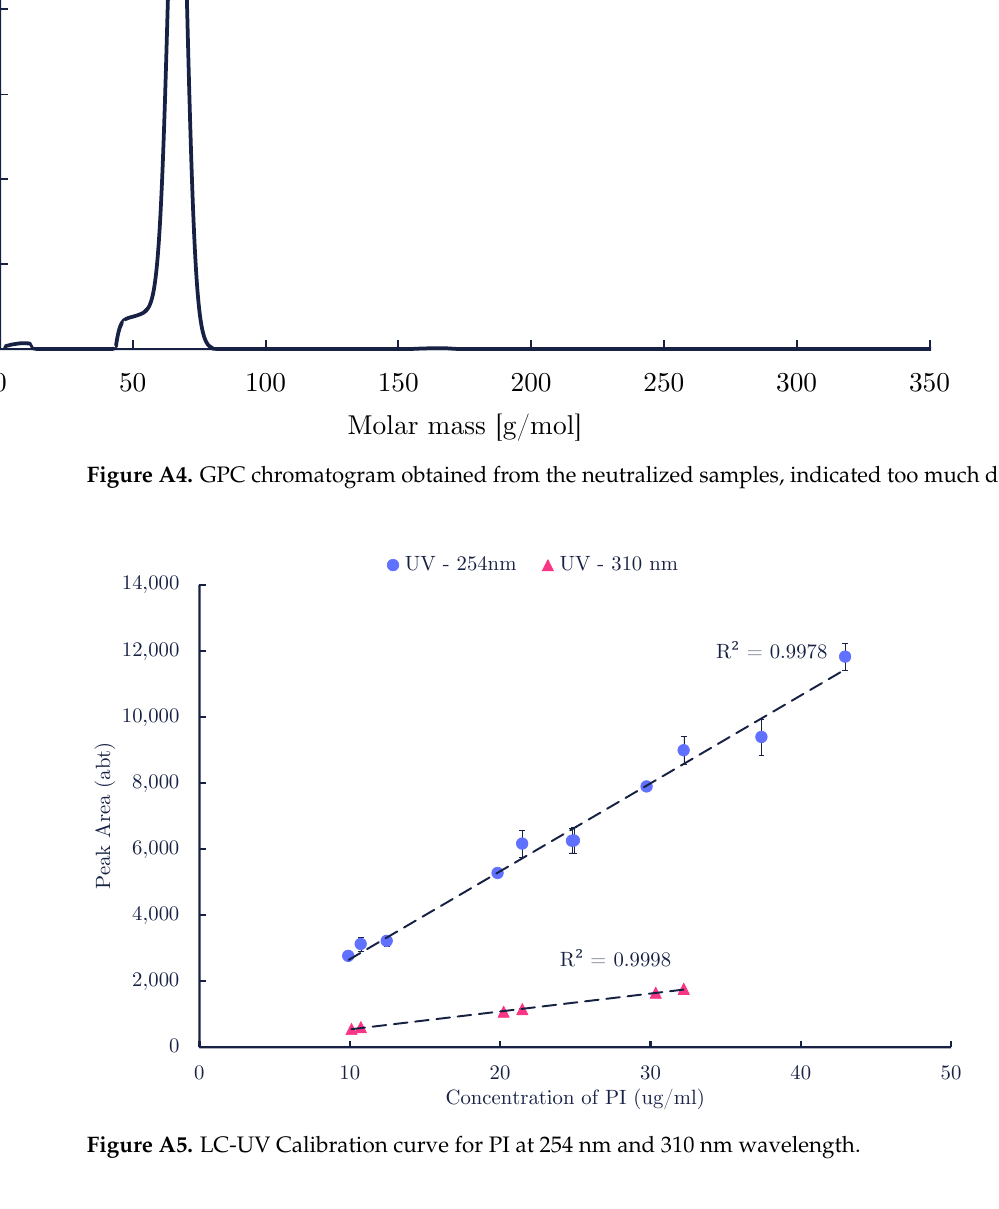
Figure A5. LC-UV Calibration curve for PI at 254 nm and 310 nm